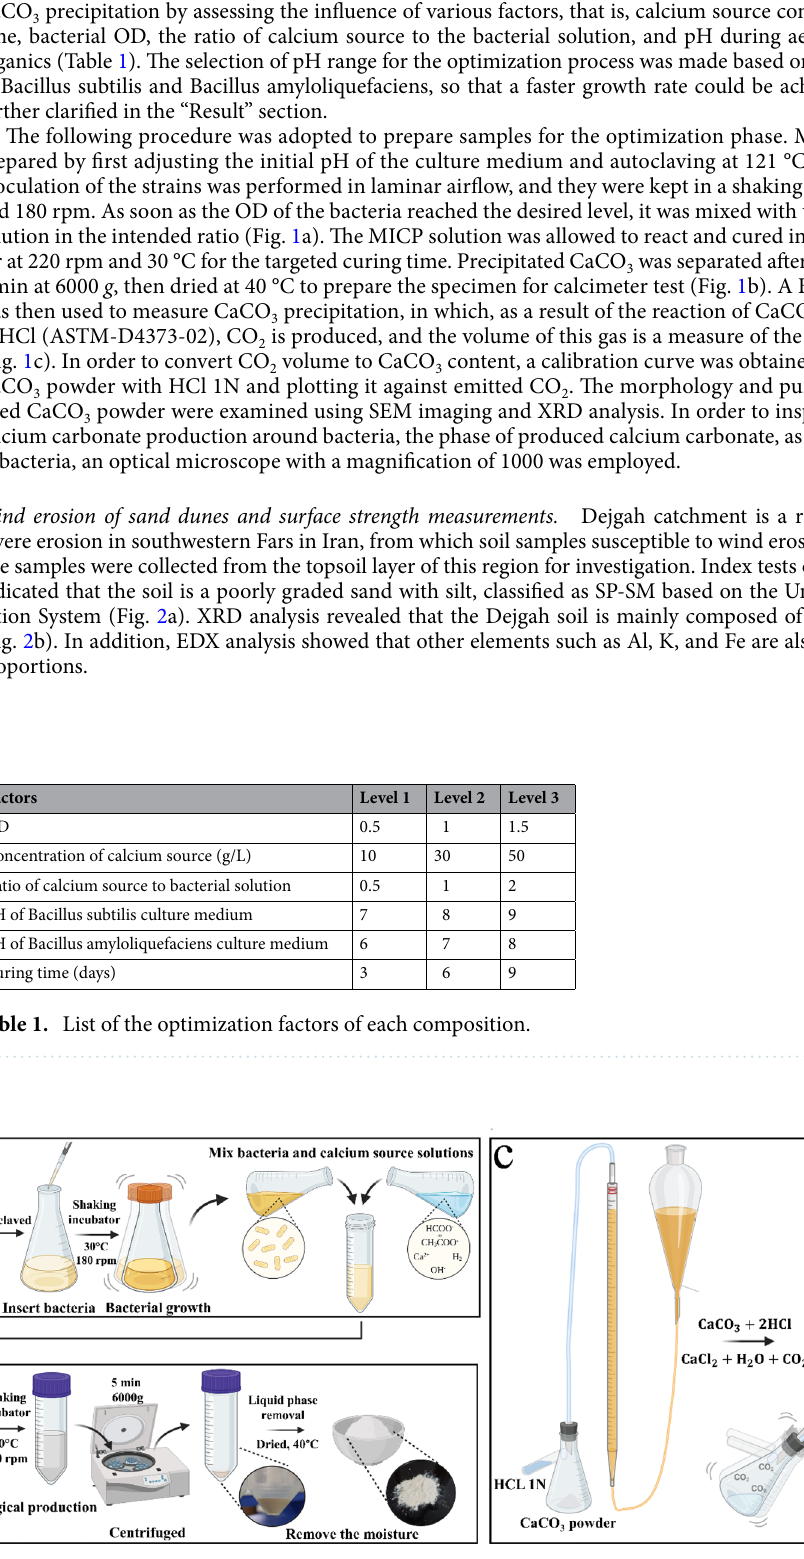
Figure 1. Schematic presentation of CaCO 3 production optimization